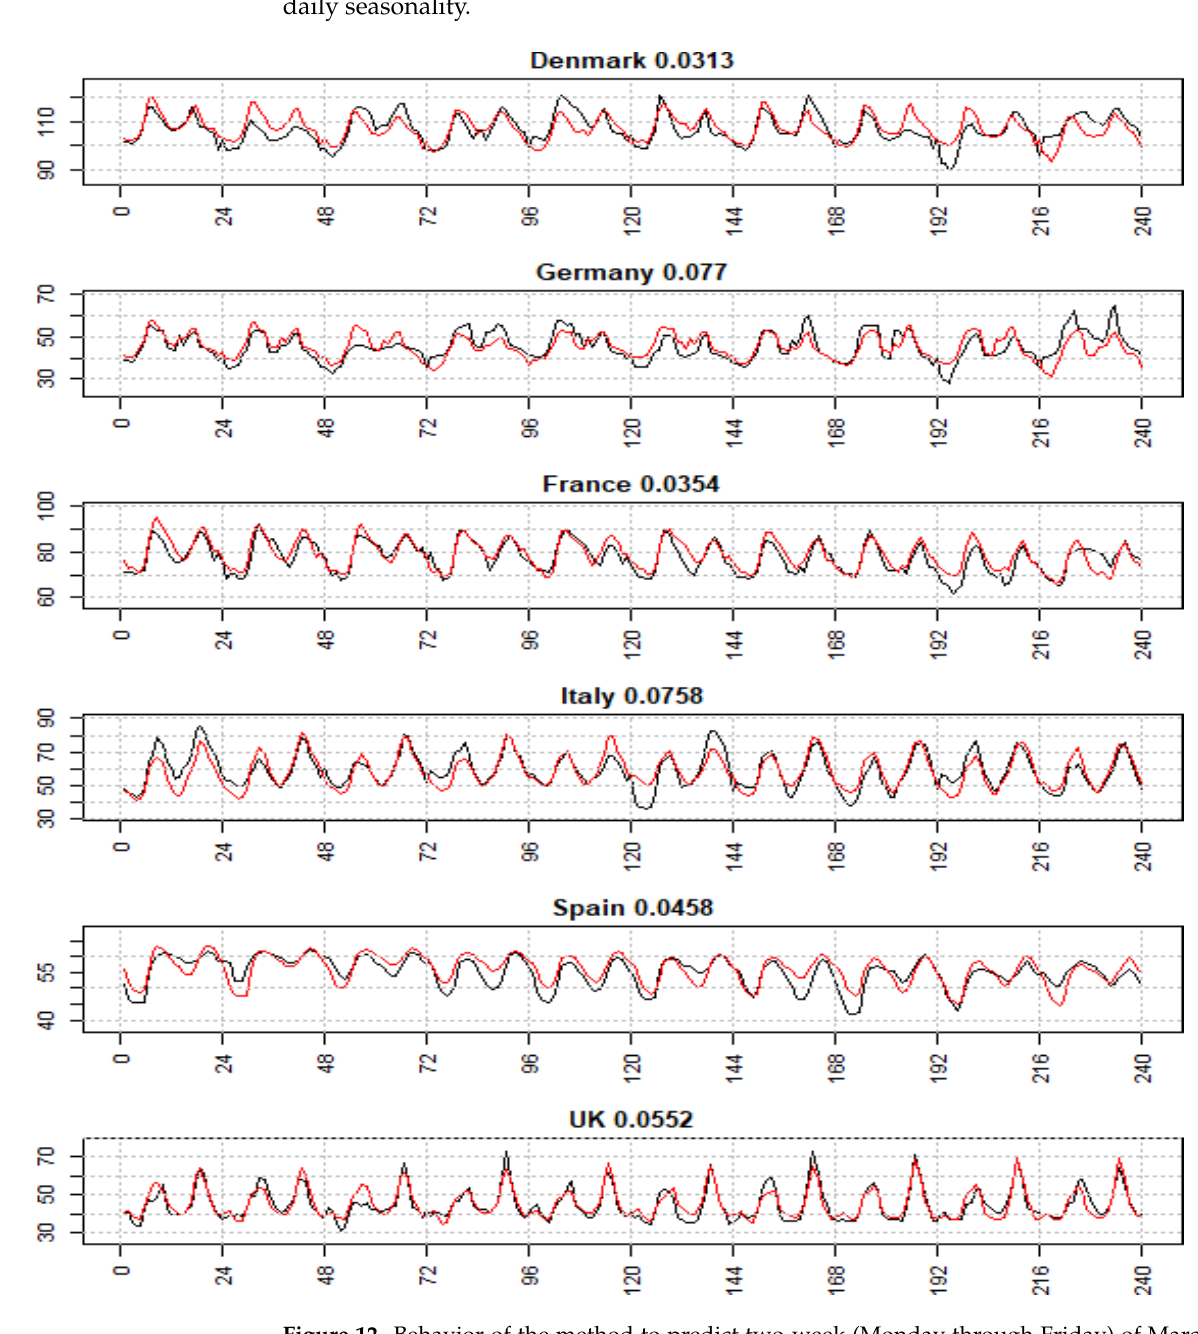
Figure 12. Behavior of the method to predict two-week (Monday through Friday) of March 2019 prices in the six market.